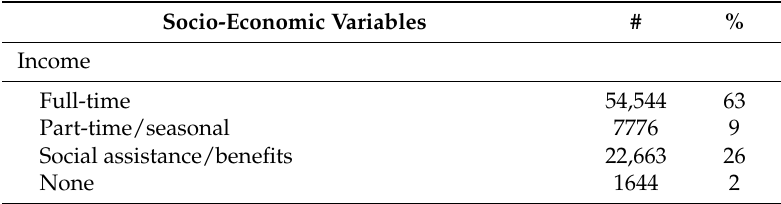
Table 2. Percentage of socio-economic risk factors for all maltreatment-related